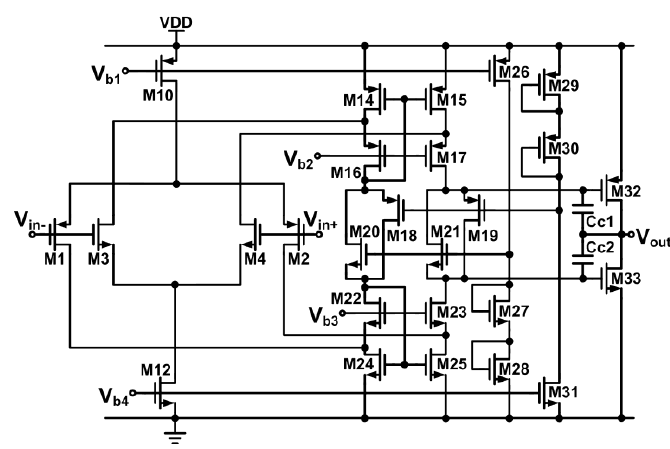
Figure 5. Schematic of the control amplifier.